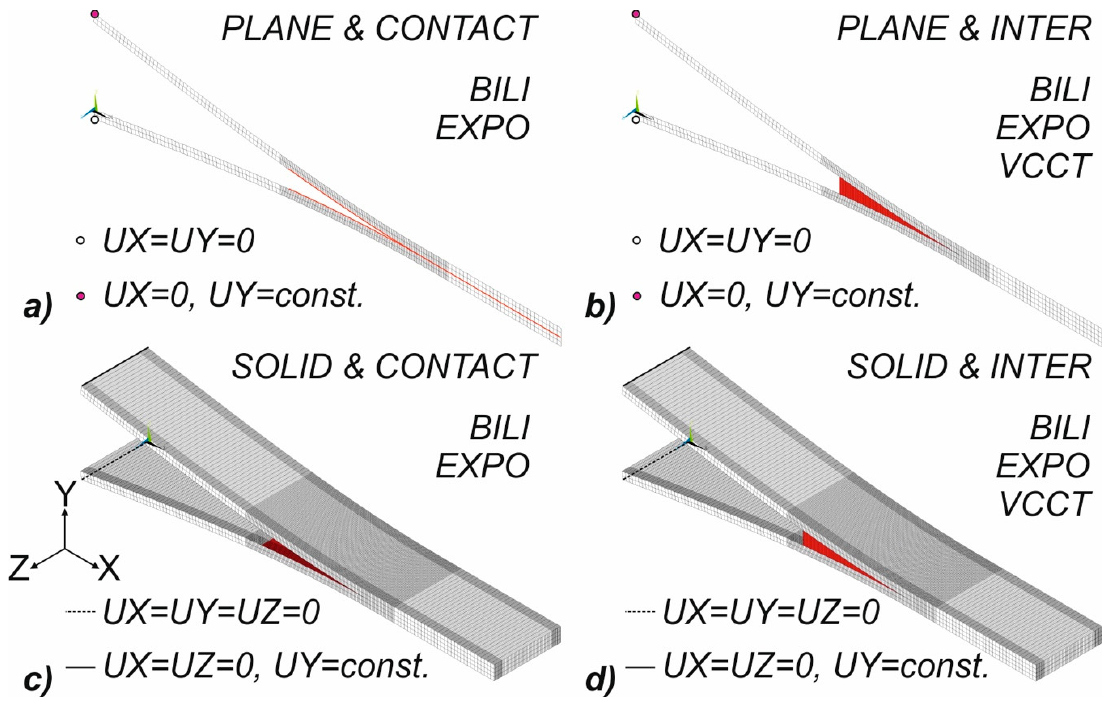
Figure 4. The analyzed numerical models of DCB specimens: Plane&Contact ( a ), Plane&Inter ( b ), Solid&Contact ( c ) and Solid&Inter ( d ).